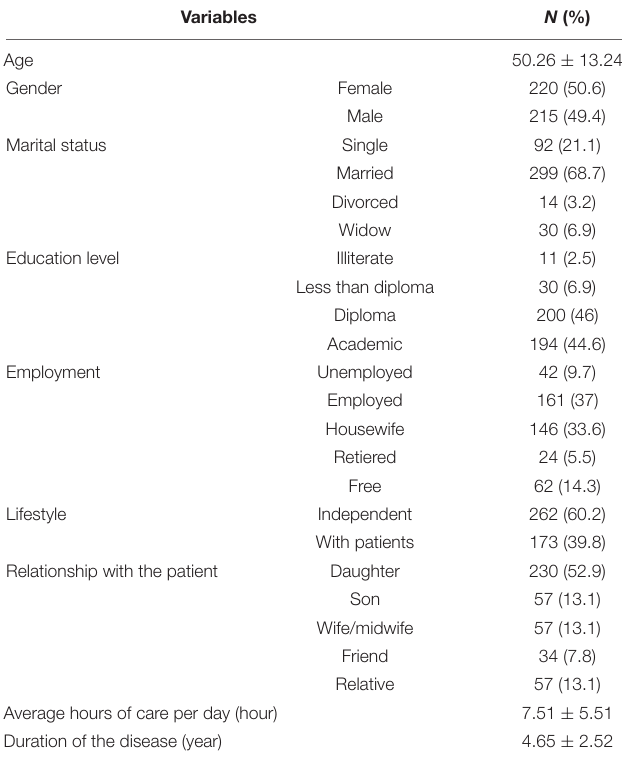
TABLE 1 | Demographic characteristics of participants ( n =